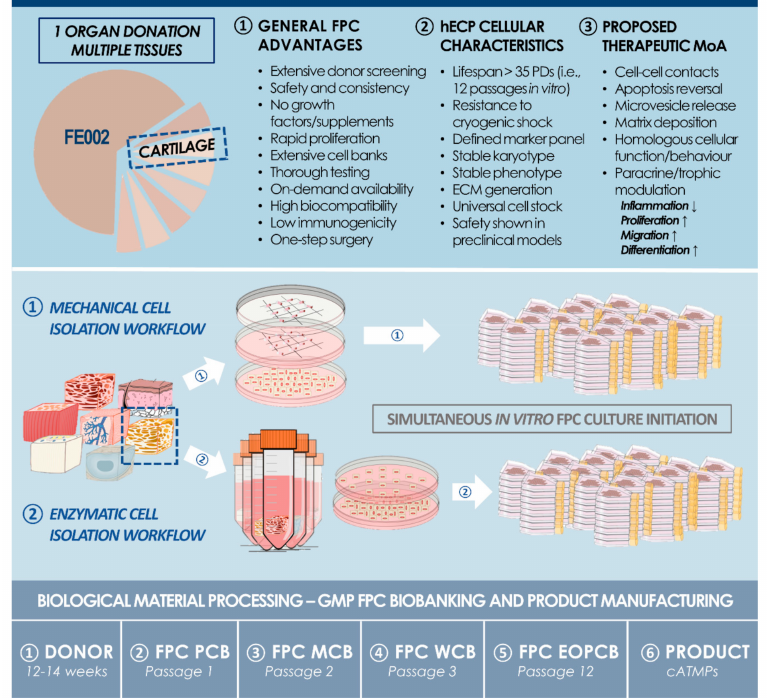
Figure 1. Overview of technological and clinical advantages of processing and using hECPs as therapeutic agents or biotechnological substrates. From a single highly controlled fetal organ do- nation (i.e., FE002 donation, 2009), various tissue biopsies (e.g., bone, cartilage, intervertebral disc, lung, muscle, skin, tendon, etc.) were bioprocessed for FPC isolation, parallelly using both enzy- matic and non-enzymatic methods. Optimized and consistent tissue procurement methodologies, cell culture initiation, and FPC biobanking workflows allow for thorough transversal and longi- tudinal testing to be performed along the product manufacturing continuum, ensuring optimal quality and safety of end-products. cATMP, combined advanced therapy medicinal product ; ECM, Extra-cellular matrix ; EOPCB, End of production cell bank ; FPC, Fetal progenitor cell ; GMP, Good man- ufacturing practices ; MCB, Master cell bank ; MoA, Mechanism of action ; PCB, Parental cell bank ; PD, Population doubling ; WCB, Working cell bank